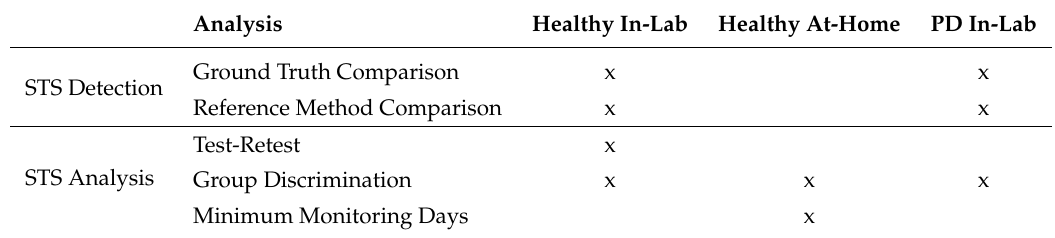
Table 1. Summary of the type of analyses that were performed on datasets from different